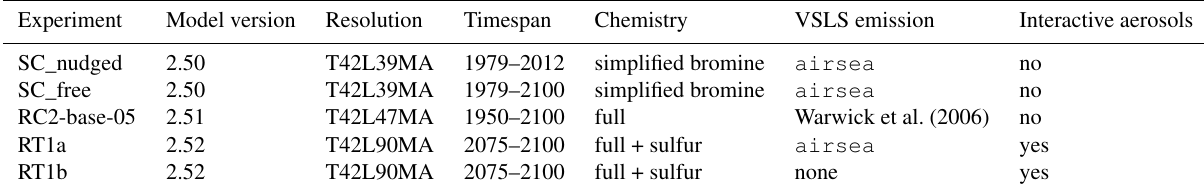
Table 1. EMAC model experiments used in this study. All experiments follow the RCP6.0 scenario of GHG emissions and have accordingly prescribed SST and SIC from